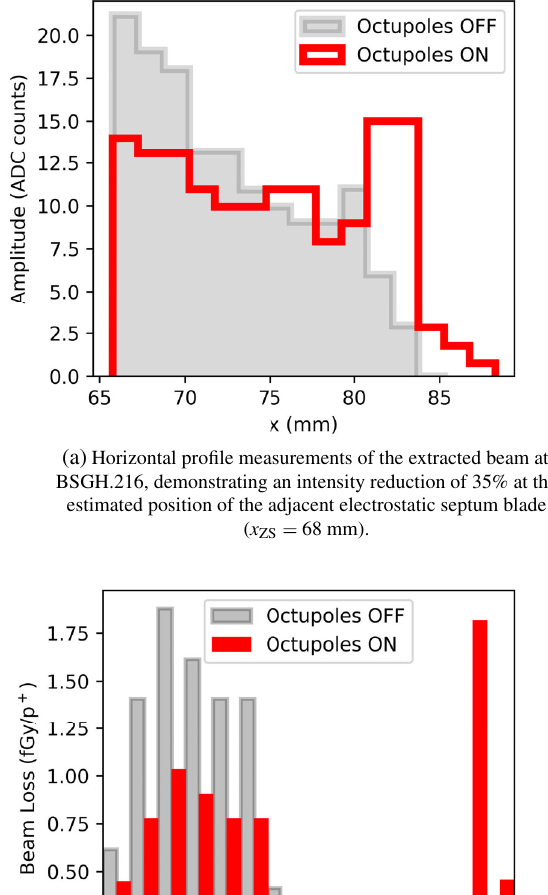
FIG. 16. Extraction measurements showing the beam distribu- tion and beam loss with strong multipole fields